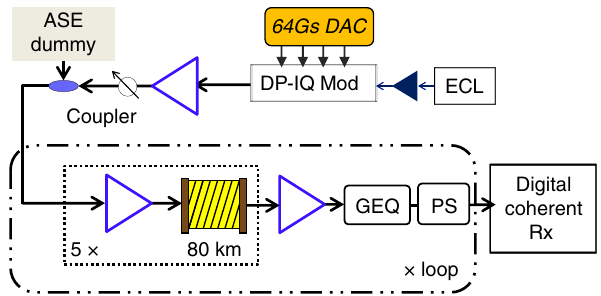
Fig. 2 System setup of the transmitter and transmission loop. DAC: digital- to-analog converter, ECL: external cavity laser, GEQ: gain equalizer, PS: polarization